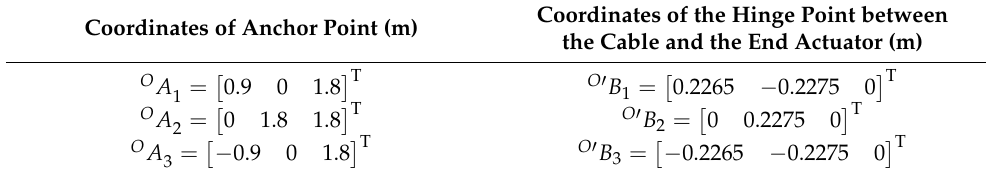
Table 1. 3 − 6 Configuration of cable-driven parallel robot.